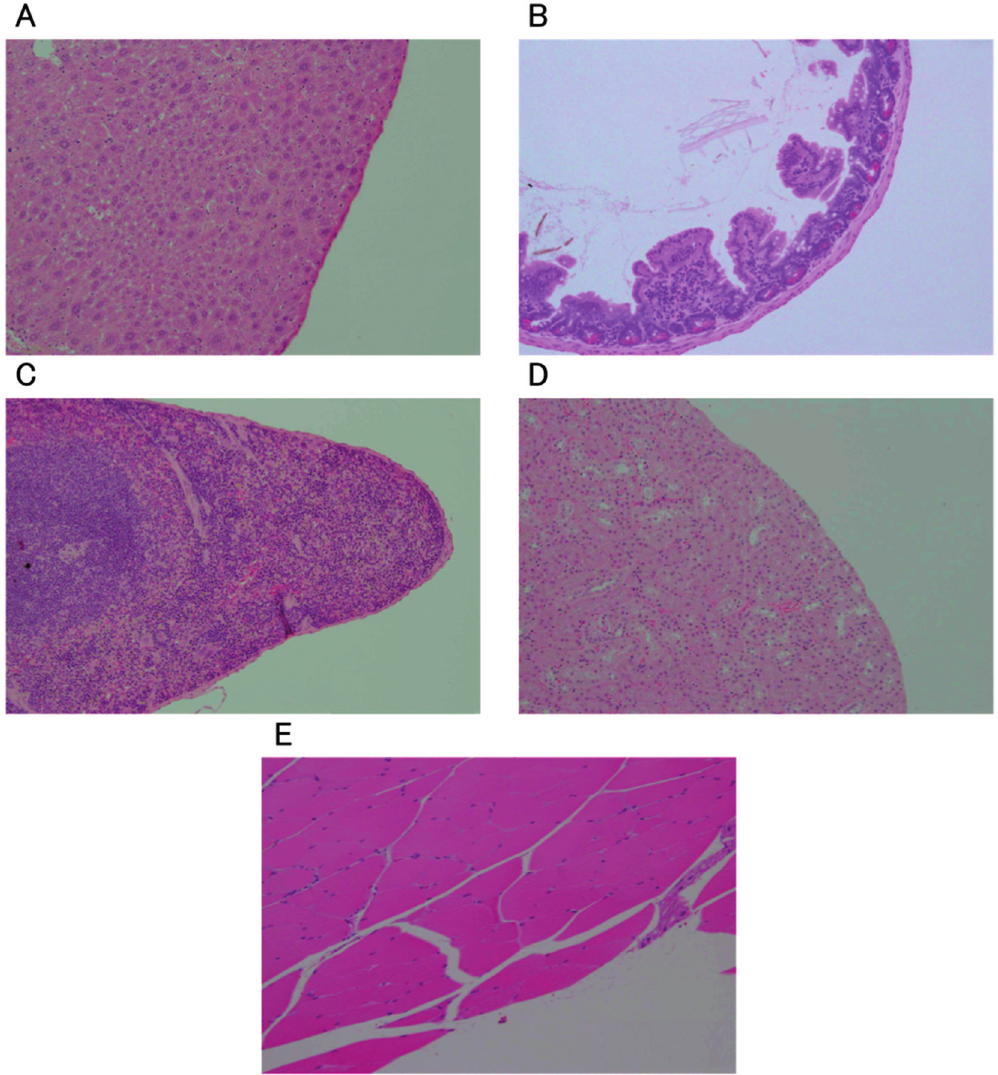
Figure 2. Histological images of normal tissues of the liver ( A ), small intestine ( B ), spleen ( C ), kidney ( D ) and muscle ( E ) 24 h after the last administration of ozonated water. All sections were observed (100×) after staining with hematoxylin and